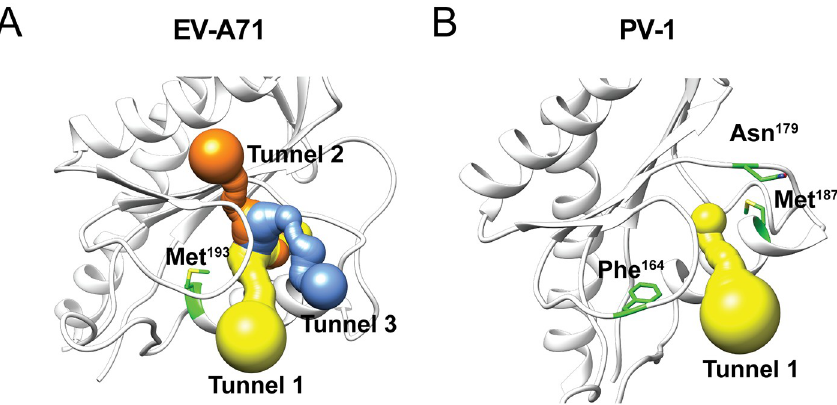
Fig 5. In silico prediction of solvent accessible tunnels reveals a binding pocket surrounding the α 2 helix of 2C. (A) The MOLE tool was used to identify solvent exposed tunnels surrounding the α 2 helix of 2C [40]. For EV-A71 the 2C crystal structure PDB: 5GRB was used, and the amino acid M193 was used as starting point [33]. (B) For PV the 2C crystal structure PDB: 5Z3Q with the amino acid M187 as starting point [41]. The primary mutations of EV-A71 and PV-1 are highlighted in green and the in silico predicted tunnels are colored in yellow, blue, and orange. Asn, asparagine; EV, enterovirus; PDB, protein database; Phe, phenylalanin; PV,